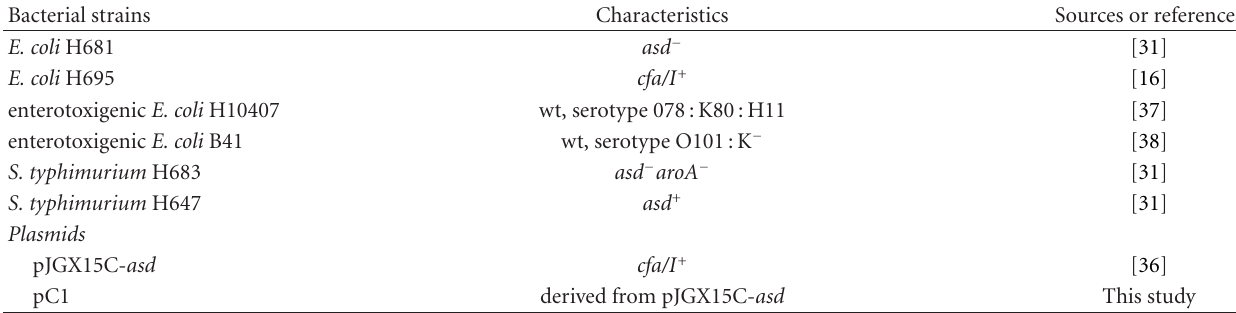
Table 1: Bacterial strains, plasmids, and their